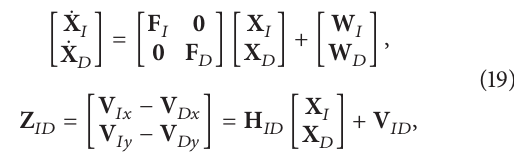
Velocity matching method is used in INS/DVL subfilter, and the state equation and measurement equation are given